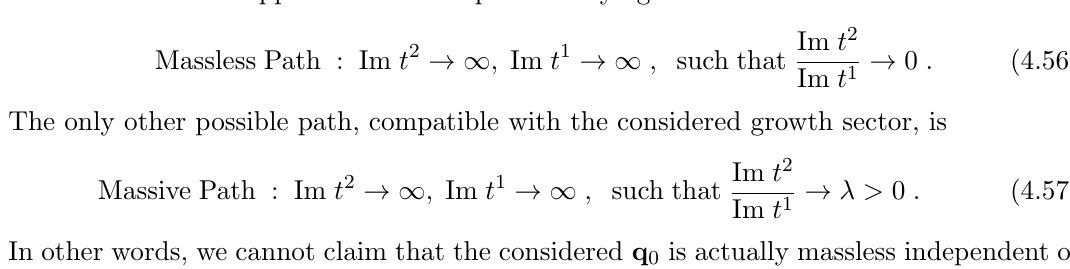
Figure 19 . The left picture shows a mixed Hodge structure on P 3 ( N (cid:0) numbers (0 ; b 0 ; b 0 ; 0). The middle picture shows a mixed Hodge structure on P 4 ( N (cid:0) with Hodge numbers (0 ; 1 ; b; 1 ; 0). The right picture shows the image of the middle picture under the action of N (cid:0) . In these diamonds, the coloured arrows label the action of N (cid:0) 1 agreement with equation (4.44) and (cid:12)gure 14. The sum of these three Hodge-Deligne diamonds is the diamond of ( F ; W (2) ) of type II c . The circle around the dot in the middle diamond indicates (2) the location of ~a (2) 0